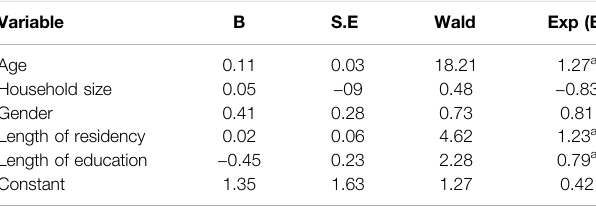
TABLE 8 | Logistic regression predicting likelihood of residents ’ favorable conservation